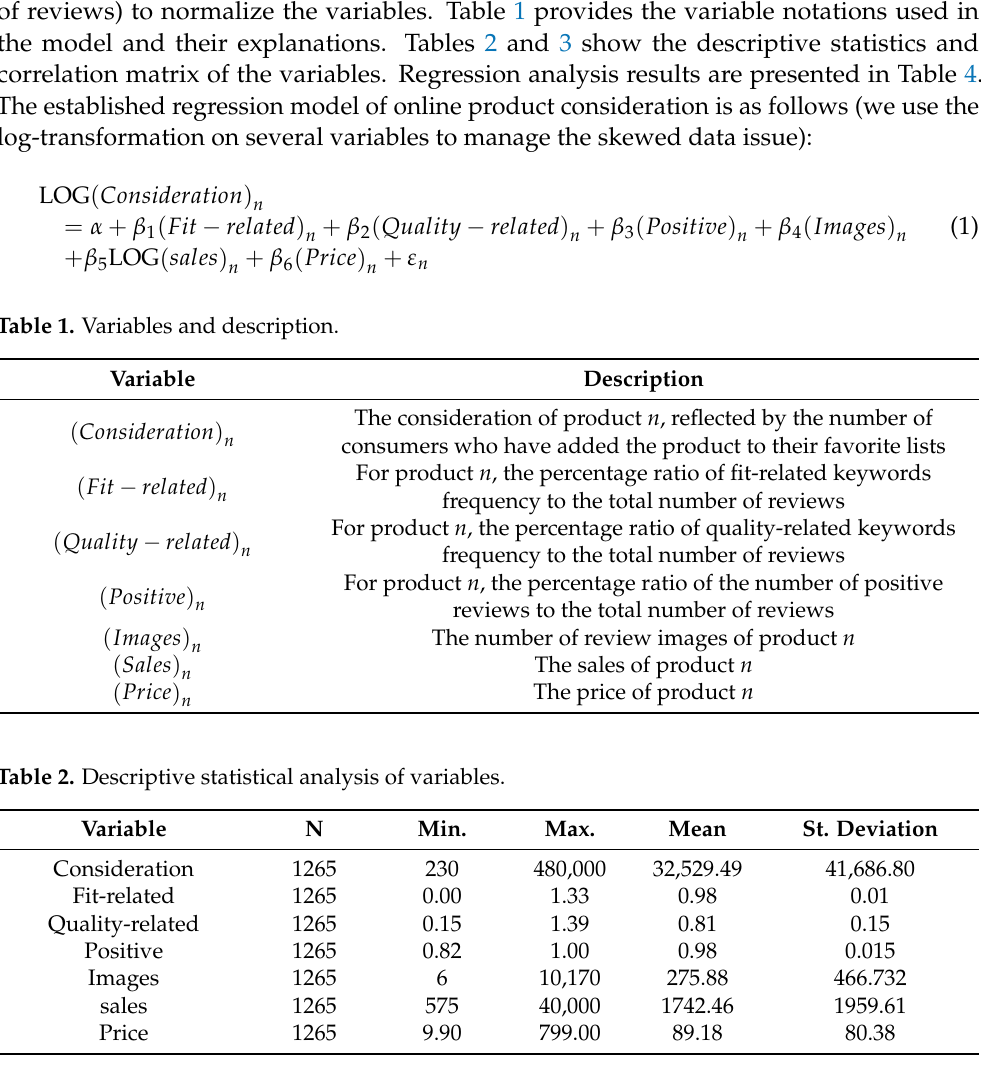
Table 1. Variables and description.